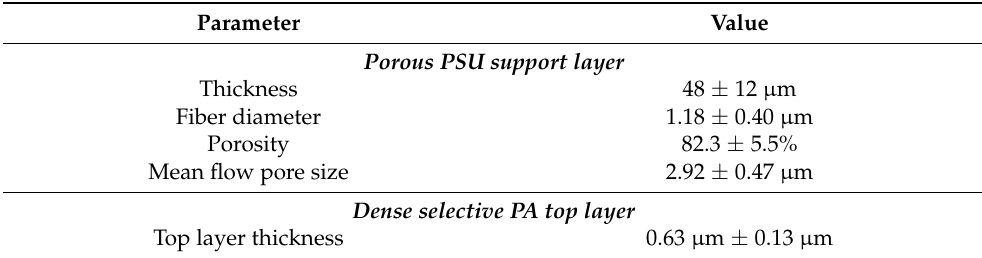
Table 2. Characteristics of the custom-made FO